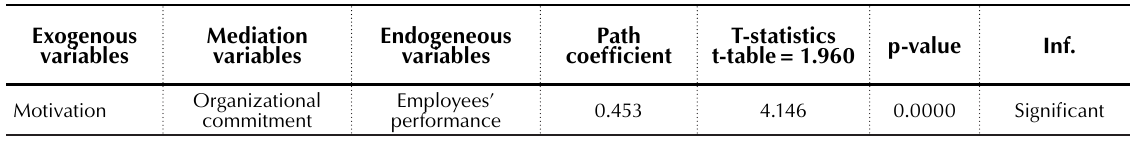
Source: Data processed (2015).